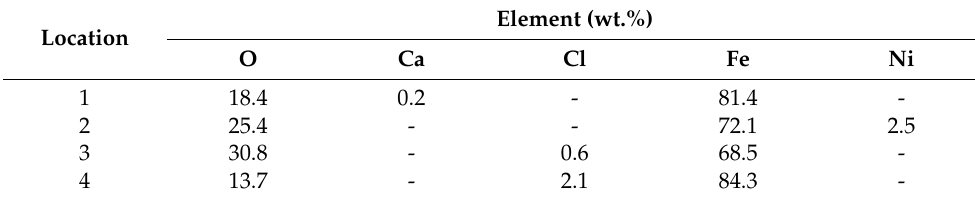
Table 10. Elemental analysis from locations in Figure 10.